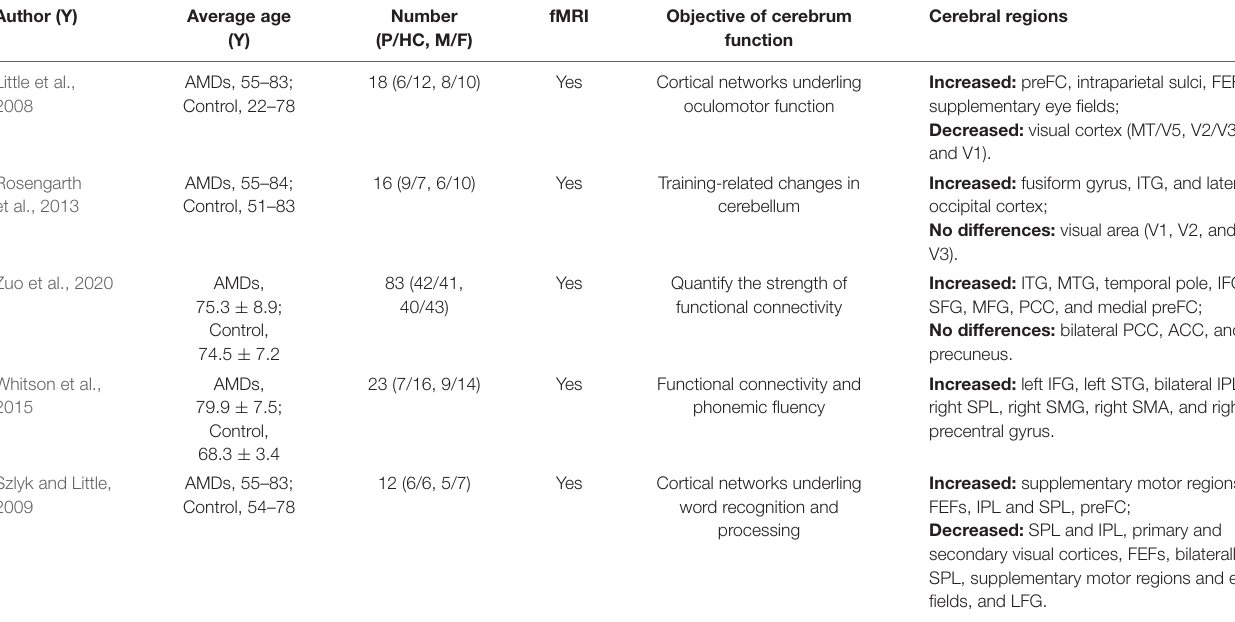
TABLE 3 | Current research status of fMRI and AMD in specific cerebral regions.